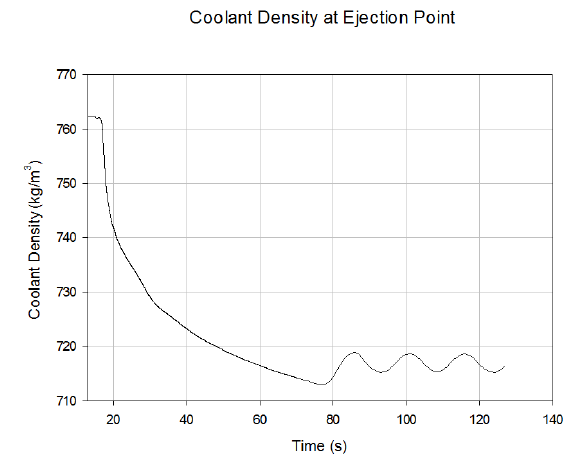
Figure 18. Coolant temperature at ejection point.